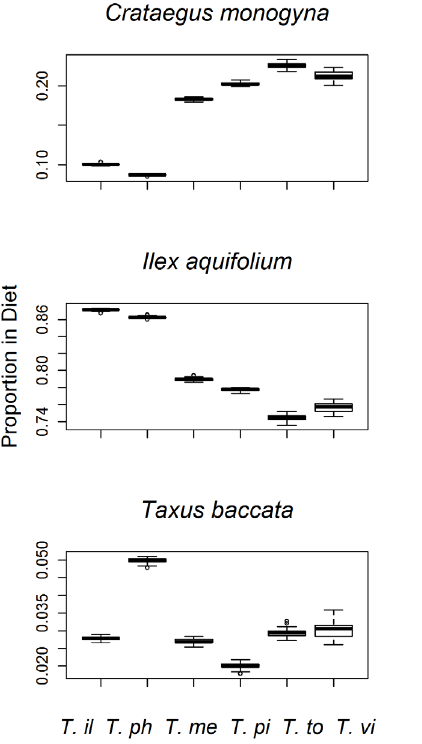
Figure 5. Different Turdus species had different diets despite the fact that no preference was built-in in the model. Bird species are T. iliacus (T. il), T. philomelos (T. ph), T. merula (T. me), T. pilaris (T.pi), T. torquatus (T. to) and T. viscivorus (T.